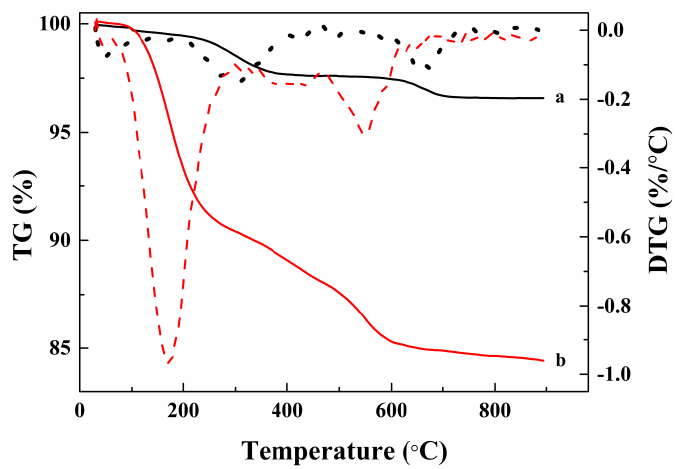
Figure 3. Thermal gravimetric analysis (TGA) and DTG curves of: (a) CaX (black), (b) IL/CaX (red).